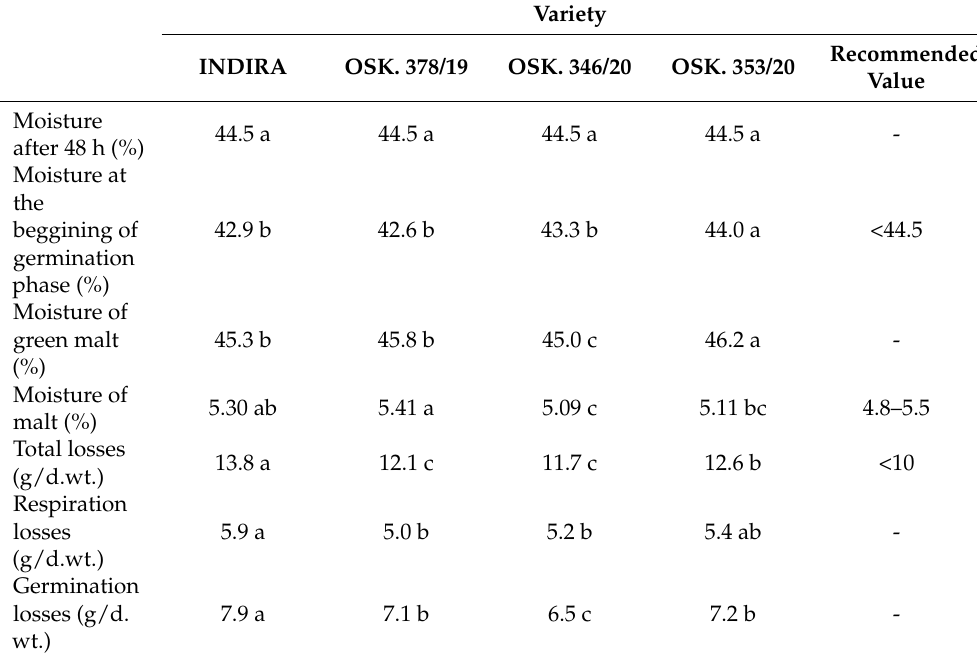
Table 5. Results of wheat germination